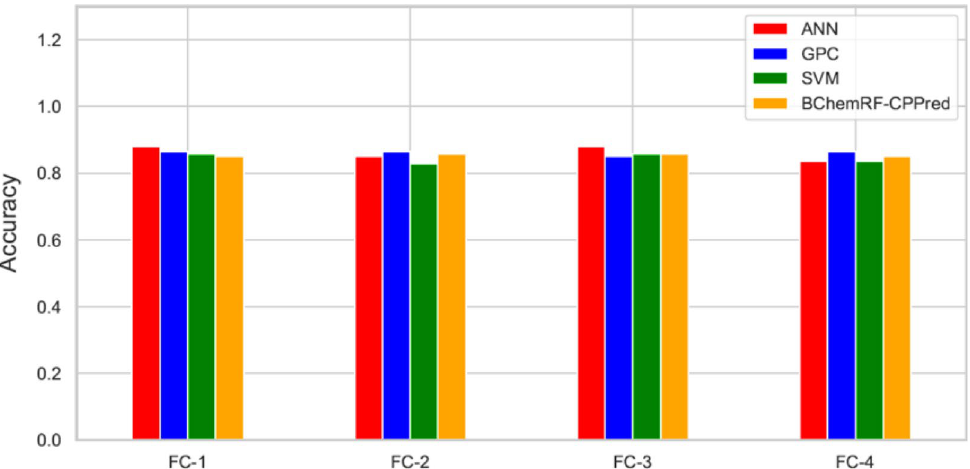
Figure 4. Accuracy of ANN (red), GPC (blue), SVM (green), and BChemRF-CPPred (orange) by FCs evaluated in the independent test, using FASTA input.